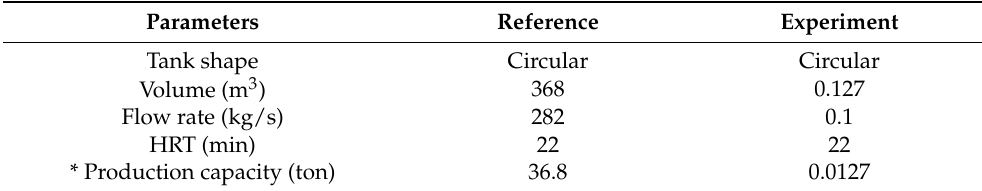
Table 1. Comparison and specifications of circular water tanks used in this experiment and northern Norway for Atlantic salmon production.